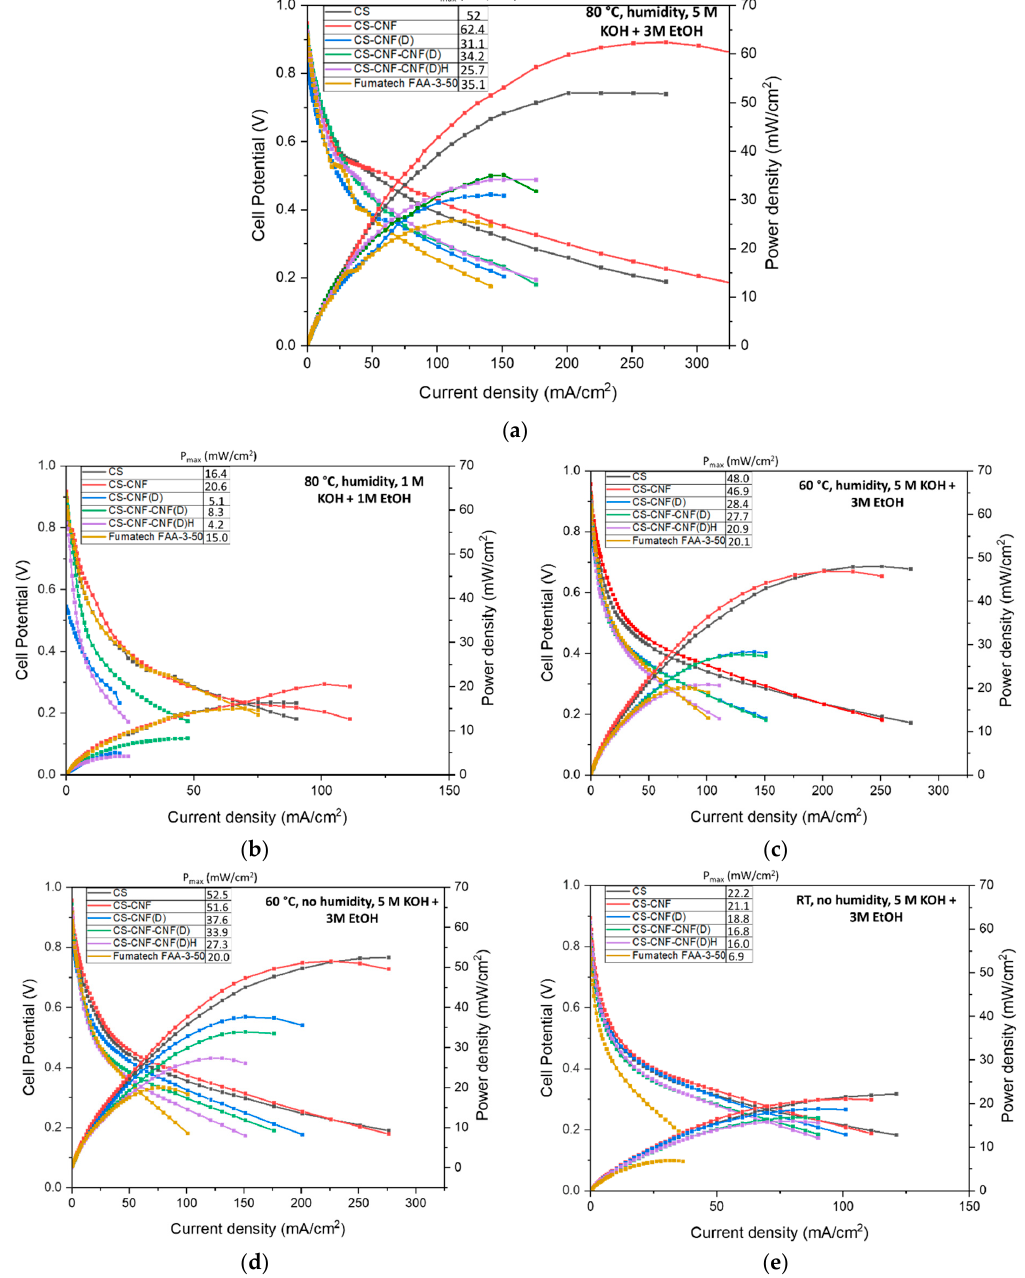
Figure 11. The results of membrane testing in the alkaline anion exchange membrane fuel cells (AAEMFC) under different operating conditions. Cell voltage and power density versus current density plots using CS membranes with or without CNF and CNF(D) fillers and a commercial Fumatech FAA-3-50 under different operating conditions: ( a ) 80 °C, humidified oxygen, and a fuel mixture of 5 M KOH and 3 M EtOH, ( b ) 80 °C, humidified oxygen, and a fuel mixture of 1 M KOH and 1 M EtOH, ( c ) 60 °C, humidified oxygen, and a fuel mixture of 5 M KOH and 3 M EtOH, ( d ) 60 °C, without oxygen humidification, and a fuel mixture of 5 M KOH and 3 M EtOH, ( e ) RT, without oxygen humidification, and a fuel mixture of 5 M KOH and 3 M EtOH.